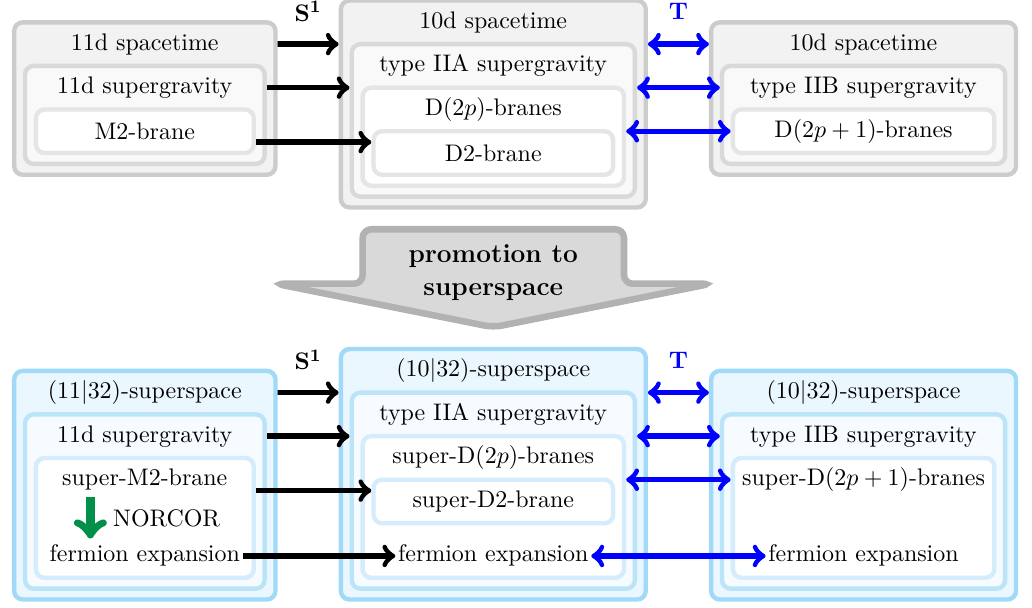
Figure 2 . A schematic map of the procedures investigated in this work. We work in superspace, and in order to do so profitably we generalize the string duality web to superspace. We generalize the S 1 compactification from 11-dimensional supergravity to type IIA, and we generalize the T-duality procedure connecting type IIA and type IIB to superspace. This allows us to carry the elegant geometric treatment of the ‘normal coordinate’ (NORCOR) method in 11-dimensional supergravity over to type II supergravity, circumventing the difficulty in applying that treatment directly in those theories. This method allows us to calculate the expansion of actions of branes in orders of the worldvolume fermions. We have presented example calculations up to quartic order in fermions for the M2-brane and the D2-brane in this work, although the methods we have presented are in principle applicable to any order in